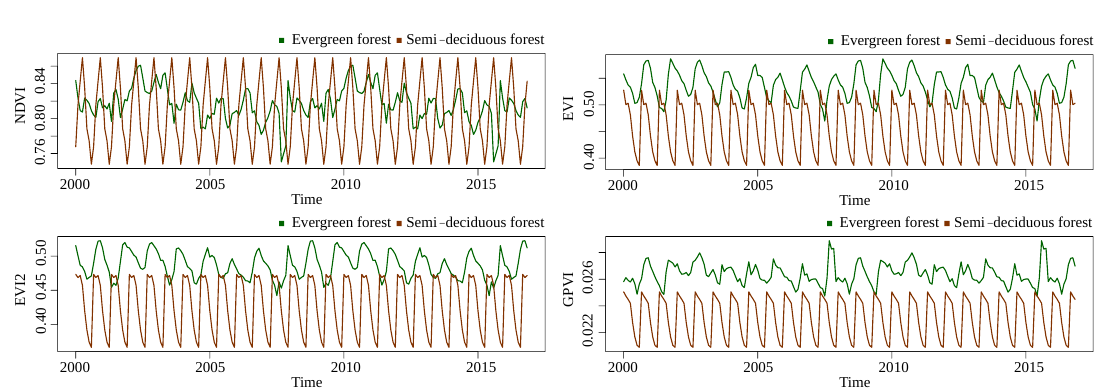
Figure 10. Time series for evergreen forest/semi-deciduous forest discrimination